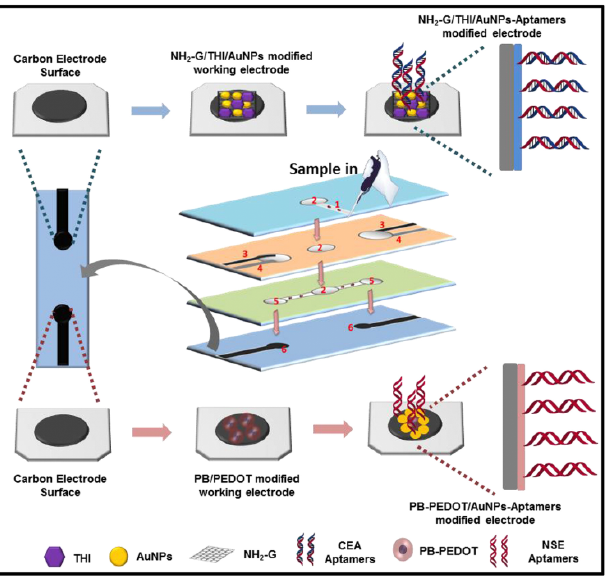
Figure 6. Fabrication and modification process of the multi-parameter electrochemical paper- based aptasensor (reprinted with permission from Ref. [82], Copyright 2019, Elsevier). aptasensor (reprinted with permission from Ref. [82], Copyright 2019,